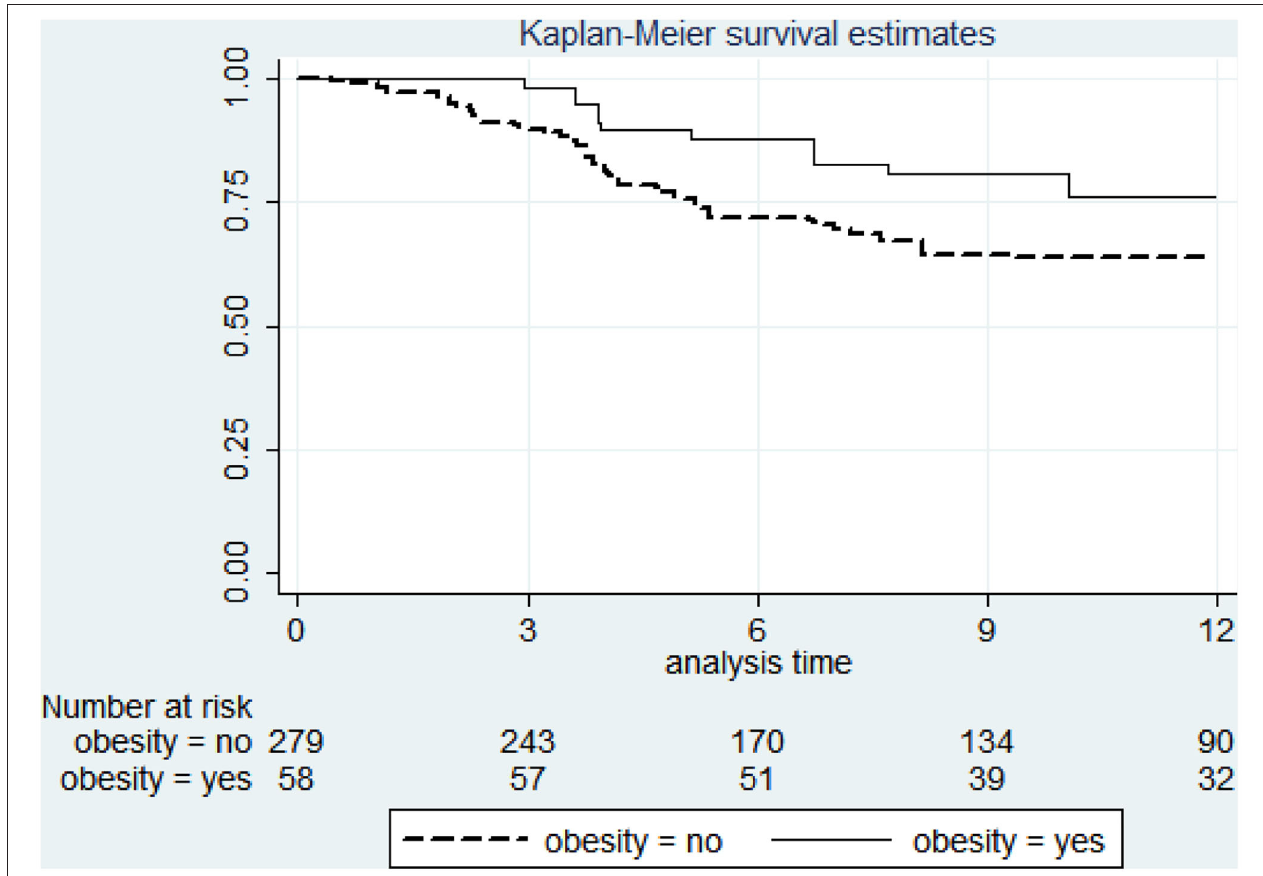
FIGURE 3 | Survival curve of secukinumab by